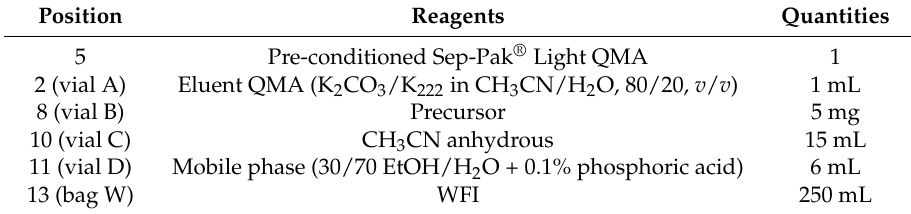
Table 2. List of reagents.